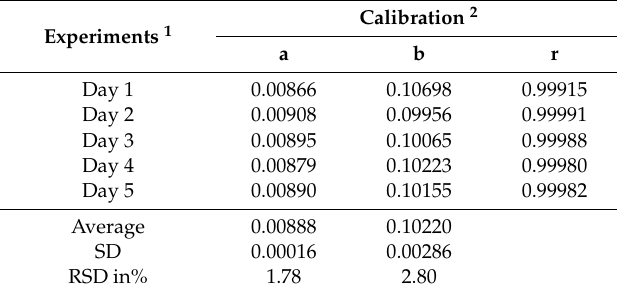
Table 1. Interday repeatability of the calibration curve.